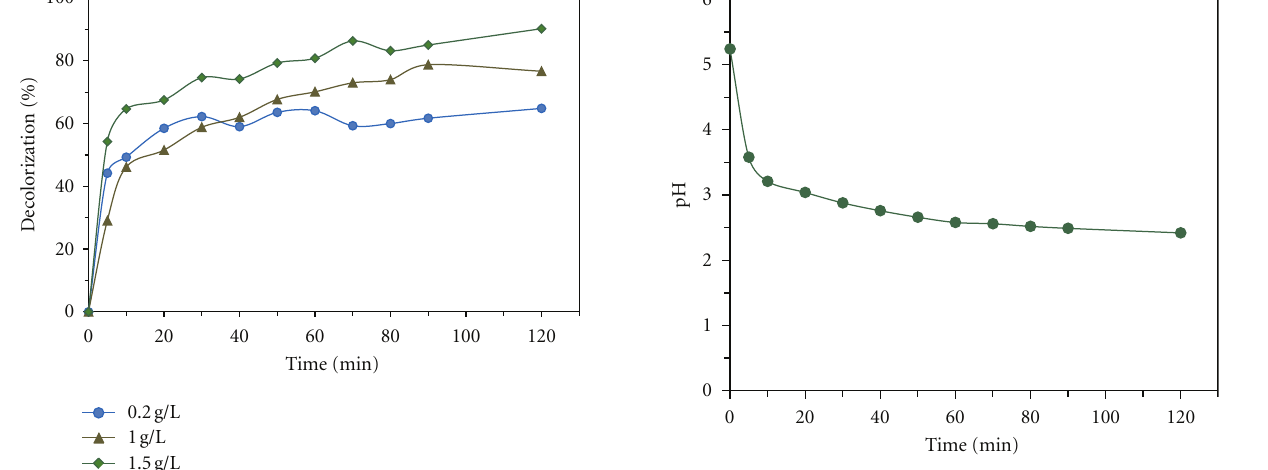
Figure 6: Variation of pH with time in